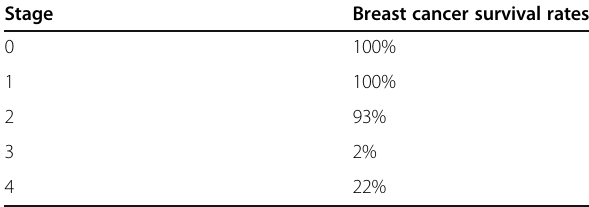
Table 2 Breast cancer survival rates at different stages [4] Stage Breast cancer survival